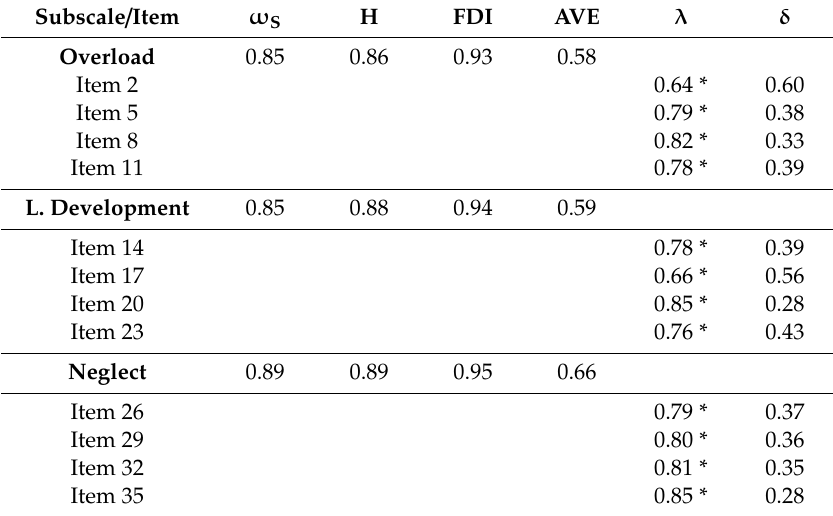
Table 5. Confirmatory factor analysis (CFA) of the Brazilian short